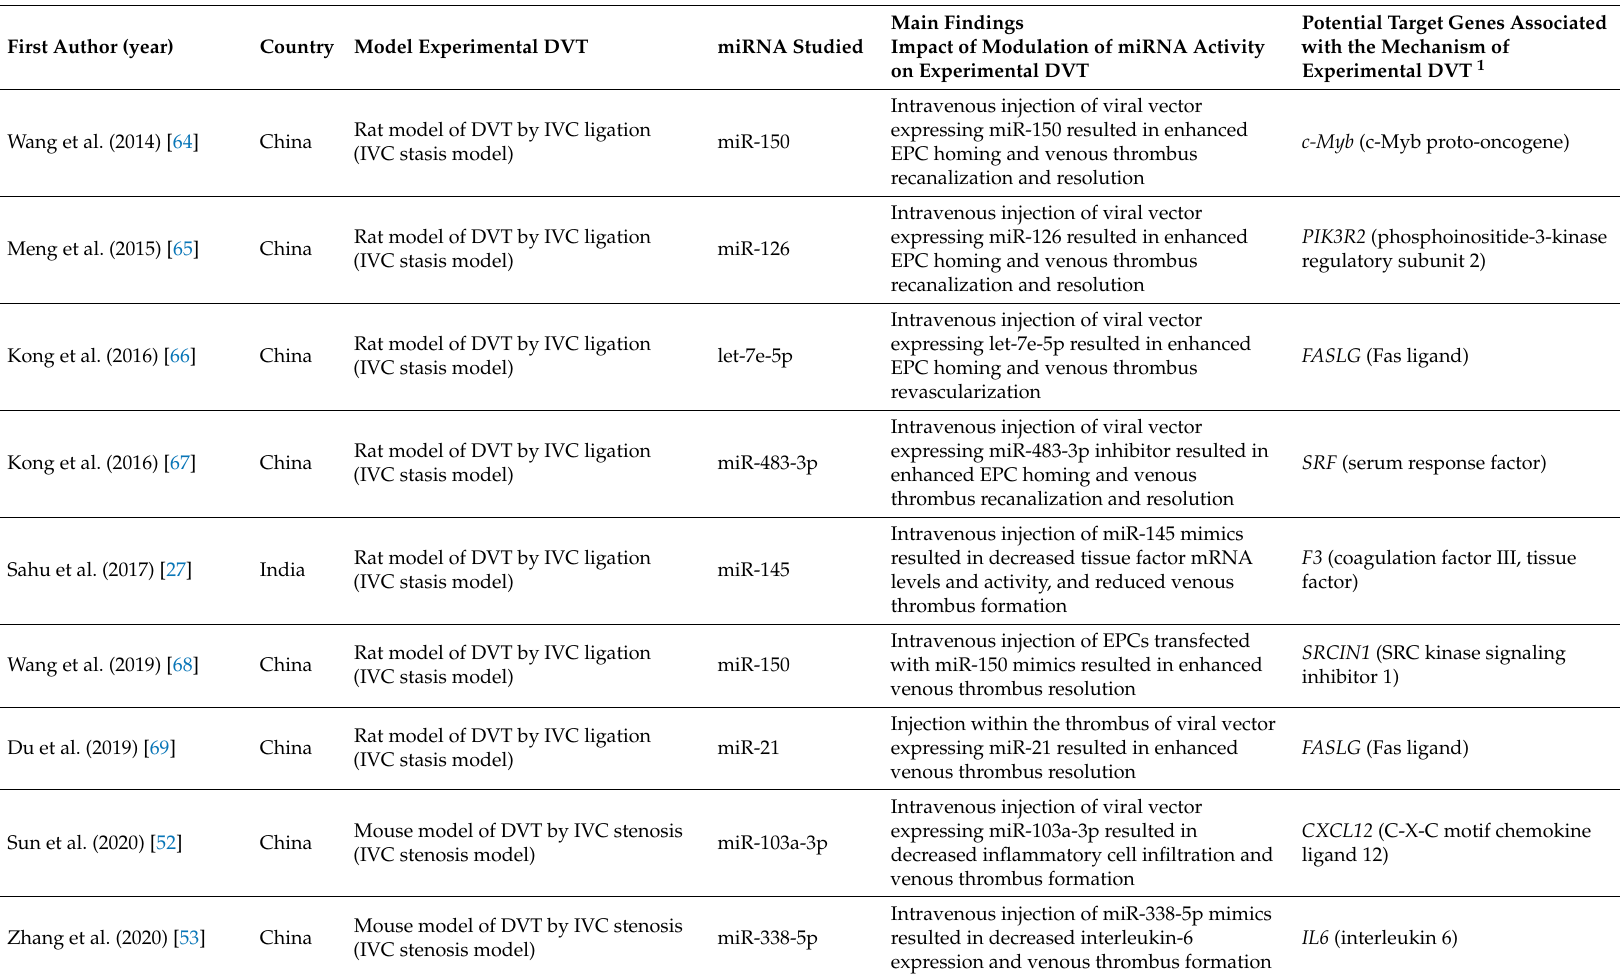
Table 3. MicroRNAs (miRNAs) and venous thrombosis in animal model